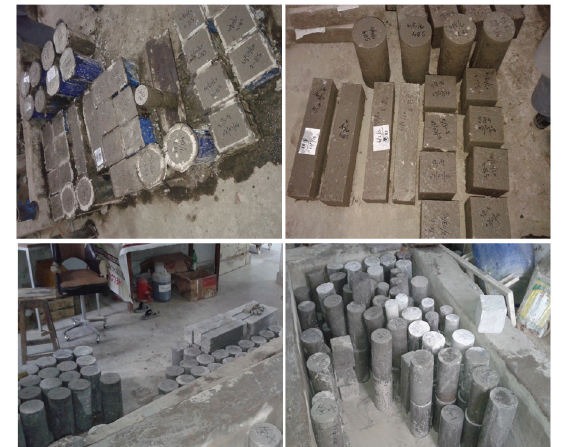
Fig. 1: Casting and curing of concrete & mortar specimens